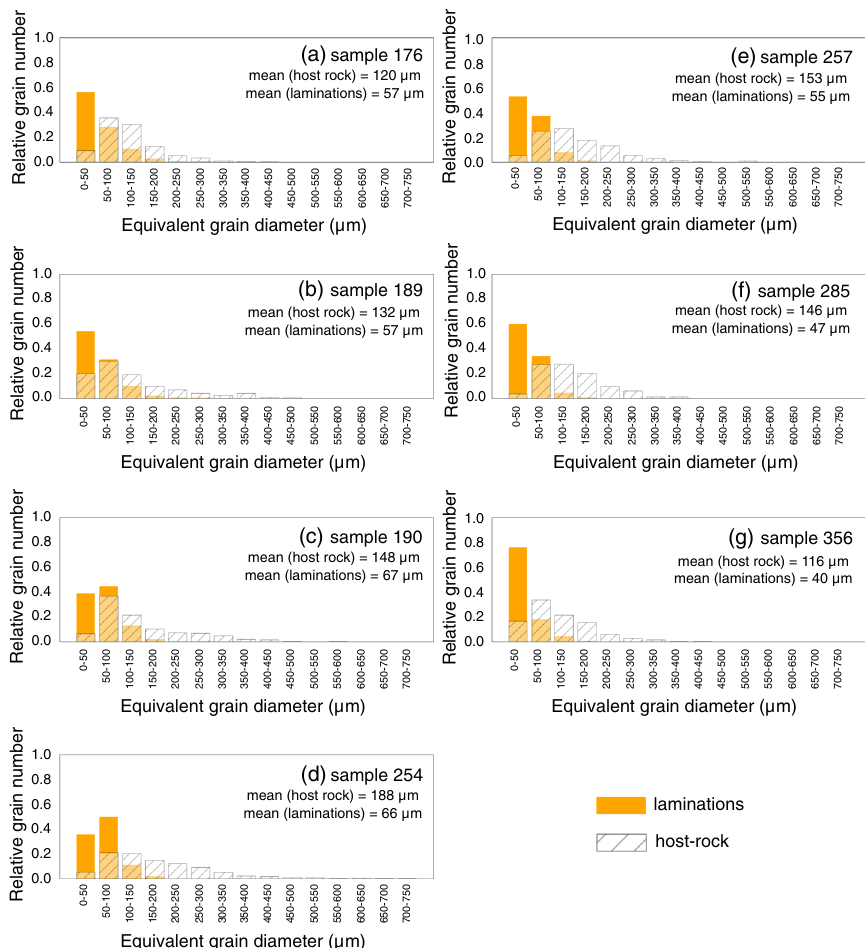
Fig. 7 Histograms showing relative grain number as a function of equivalent grain diameter for each of the seven cores investigated in this study (shown in Fig. 3). a Sample 176. b Sample 189. c Sample 190. d Sample 254. e Sample 257. f Sample 285. g Sample 356. The orange bars show the grain size distribution in the laminations and the shaded bars show the grain size distribution in the